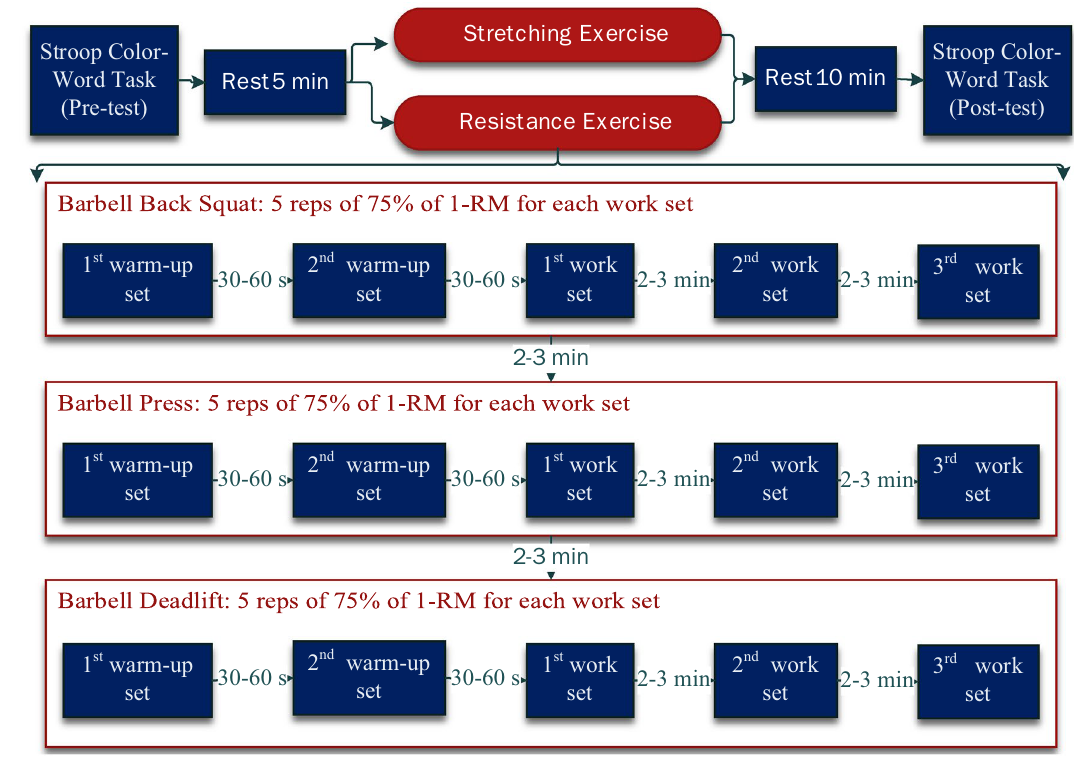
Figure 2. The procedure of exercise